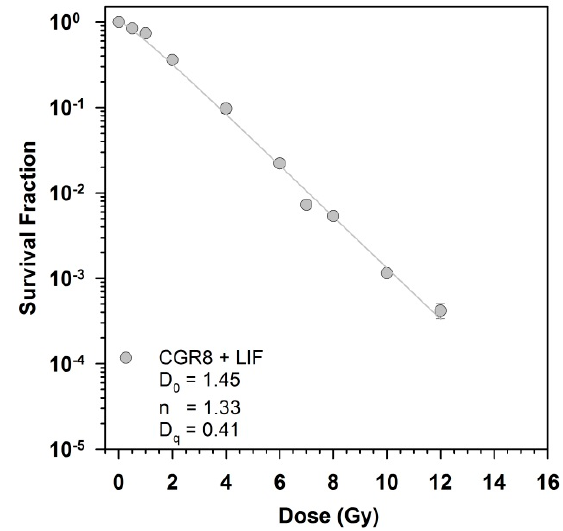
Figure 1. Clonogenic survival after exposure of murine CGR8 embryonic stem cells (mESCs) to X-rays. Survival was determined by the colony forming ability test (CFA). The cells were seeded in flasks, irradiated after reaching confluence, plated in Petri dishes immediately after irradiation and colonies were fixed and stained after 11 days incubation in presence of the leukemia inhibitory factor (LIF). The parameters D 0 (the reciprocal of the slope in the linear range of the survival curves) and the extrapolation number n of the dose e ff ect curve were calculated by a regression analysis (survival versus dose). The quasi threshold dose Dq was derived from the intersection of the extrapolated linear part of the survival curve with the 100% survival line. The survival data were fitted to the equation n S = 1 − ( 1 − e − D D 0 ) . The data of three independent experiments with 6 replicates were combined; bars show the standard error, if they are not visible, they are smaller than the symbol. The viability decreased dose-dependently up to 8 Gy three days after X-irradiation, as detected with the MTT test (Figure 2). The decrease was stronger when cells were incubated without LIF compared to growth in the presence of LIF. This difference reached significance at a dose of 4 Gy.